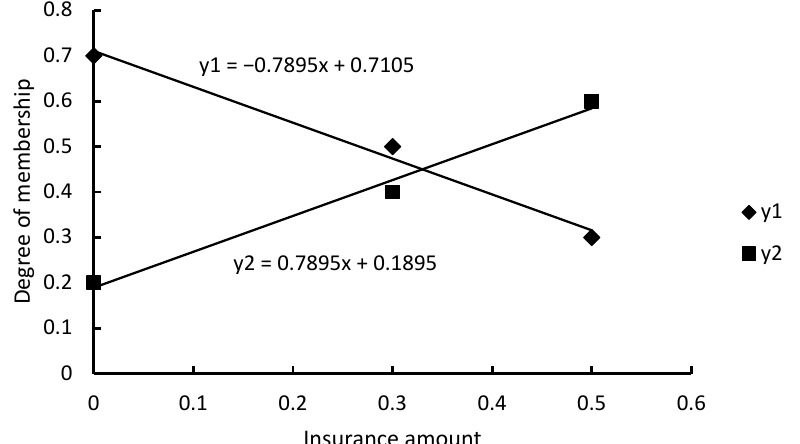
Figure A18. Single factor evaluation for the index of insurance amount (0–0.5 (inclusive) ten thou- sand yuan).